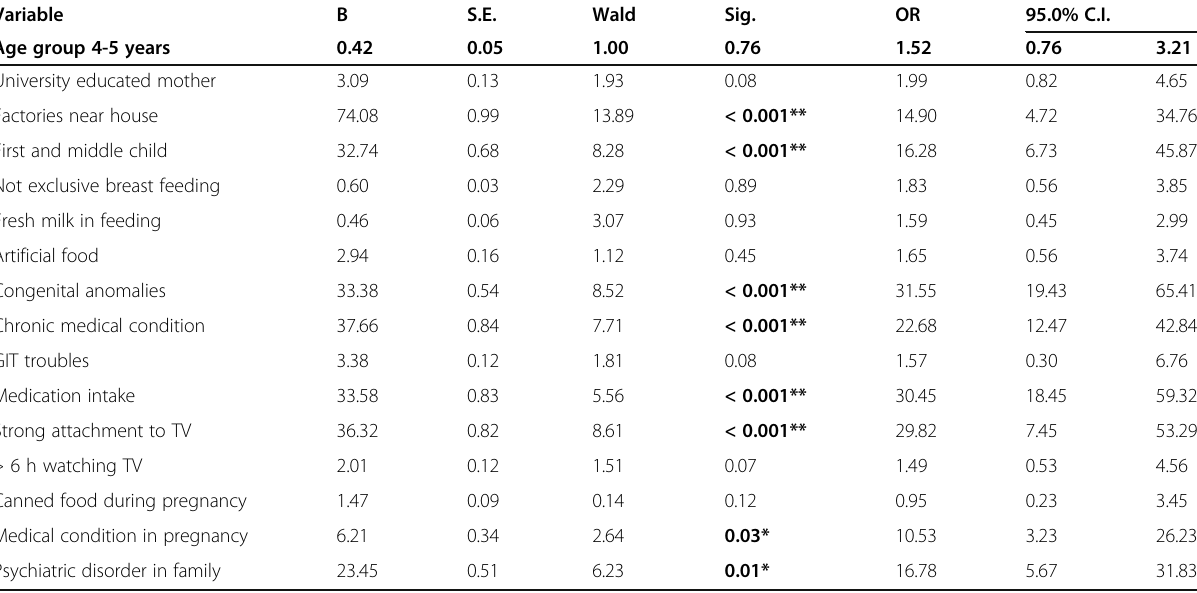
Table 8 Binary logistic regression analysis for the significant risk factors for ASD among the studied group Variable B S.E. Wald